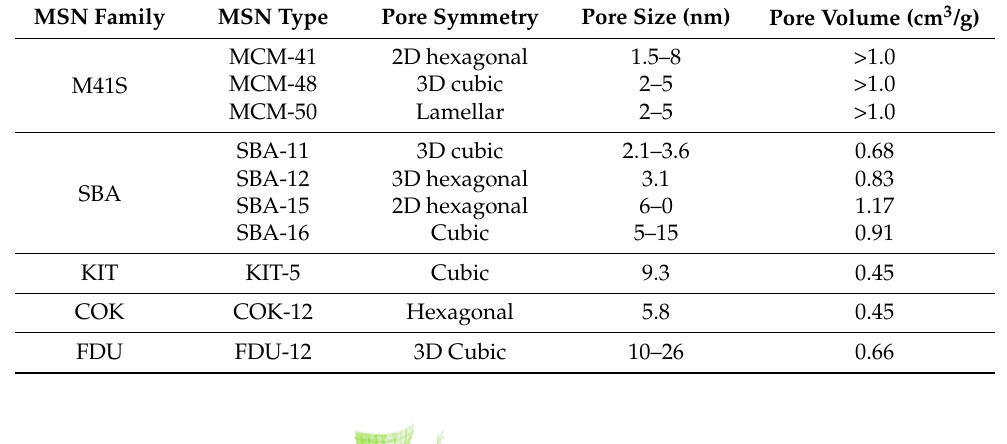
Table 1. List of different types of mesoporous silica nanoparticles (MSNs) and their characteristic properties [27].